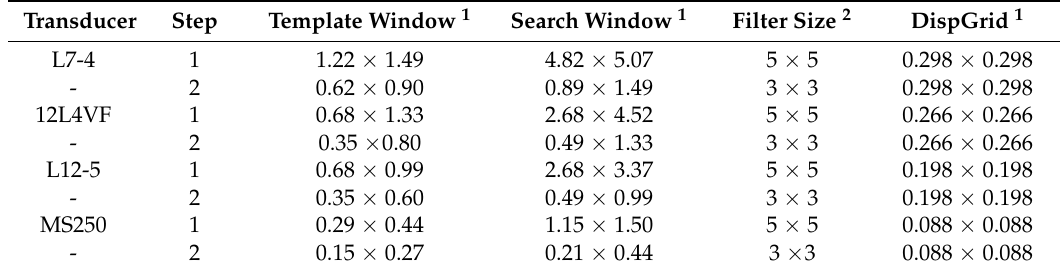
Table 2. Settings of the displacement estimation algorithm and displacement grid